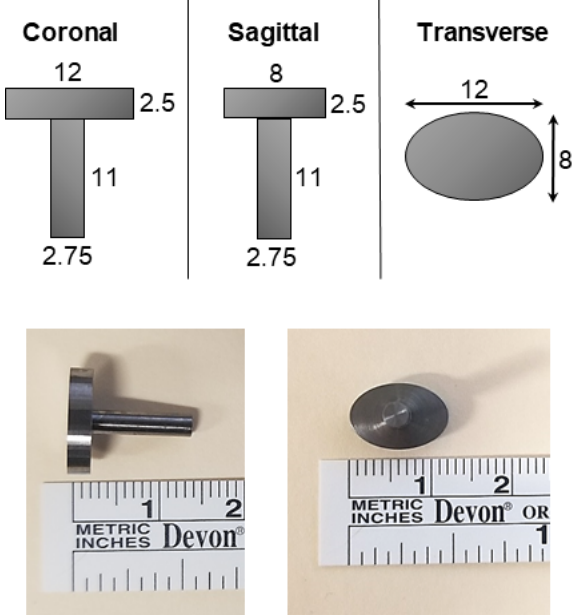
Figure 1. Custom-made titanium implant design and titanium tibial implant dimensions (in